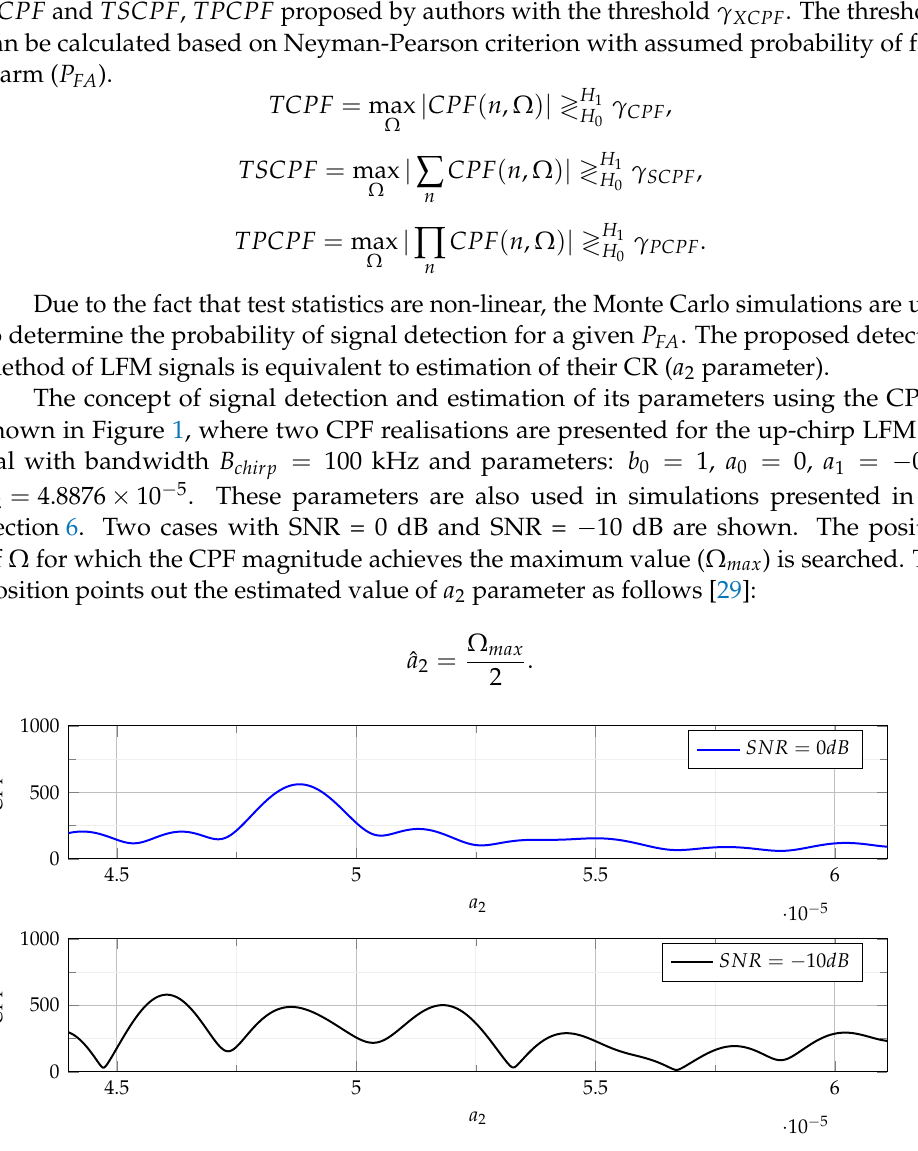
Figure 1. Examples of the CPF realisations used in the process of a 2 parameter estimation for two signals with different SNR values.